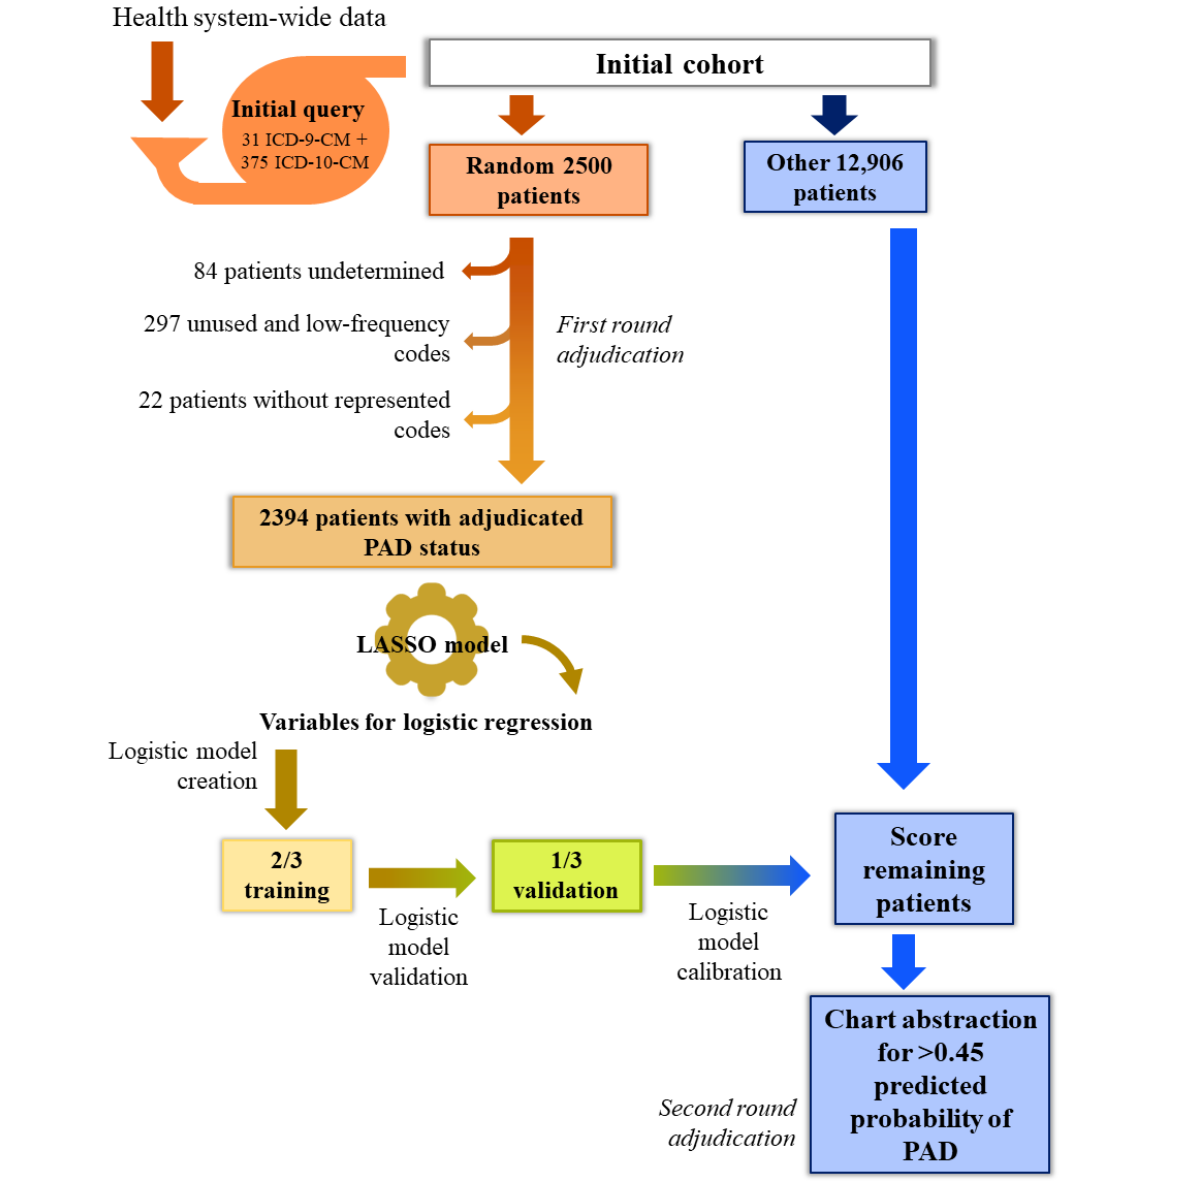
Figure 1. Overview of the chart abstraction and analysis process. LASSO: least absolute shrinkage and selection operator; PAD: peripheral artery